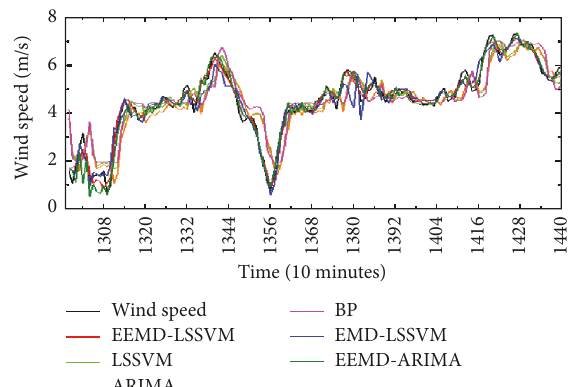
Figure 12: Two-step-ahead forecasting results (Case Two).